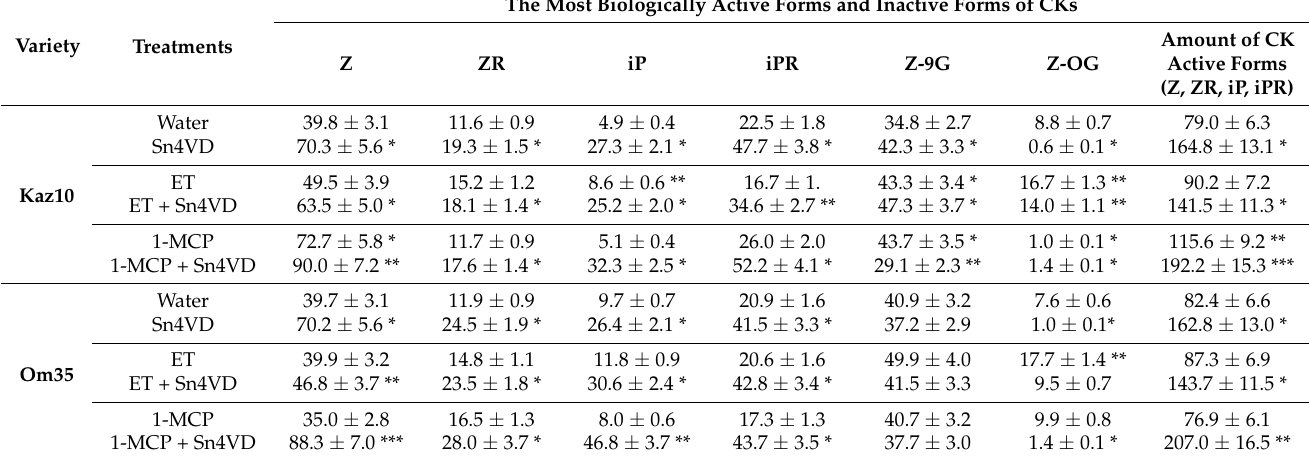
Asterisks indicate means statistically different from the control in each cultivar and different number of asterisks (*, **, ***) allows distinguishing of significantly different variants according to the LSD test (n = 6, * p < 0.05, ** p < 0.01, *** p < 0.001). Table 2. The effect of pretreatment with ethephone (ET) and 1-MCP on the content of cytokinins (pmol/g FW) in leaves of Omskaya 35 and Kazakhstanskaya cultivars 10 at 24 h after inoculation with S. nodorum avirulent isolate Sn4VD.